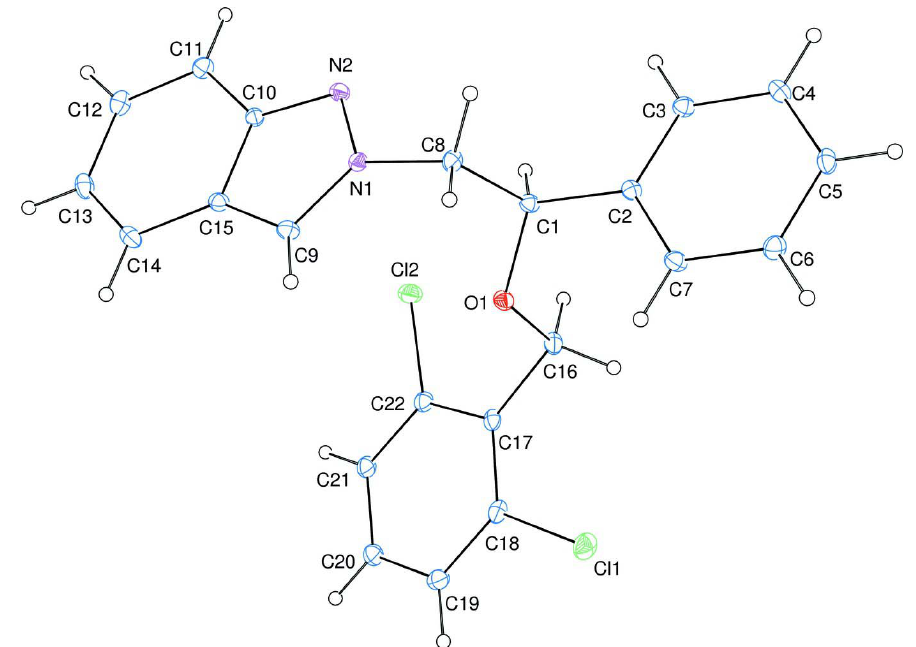
The molecular structure of the title compound with the atom-numbering scheme. Displacement ellipsoids are drawn at the 50% probability